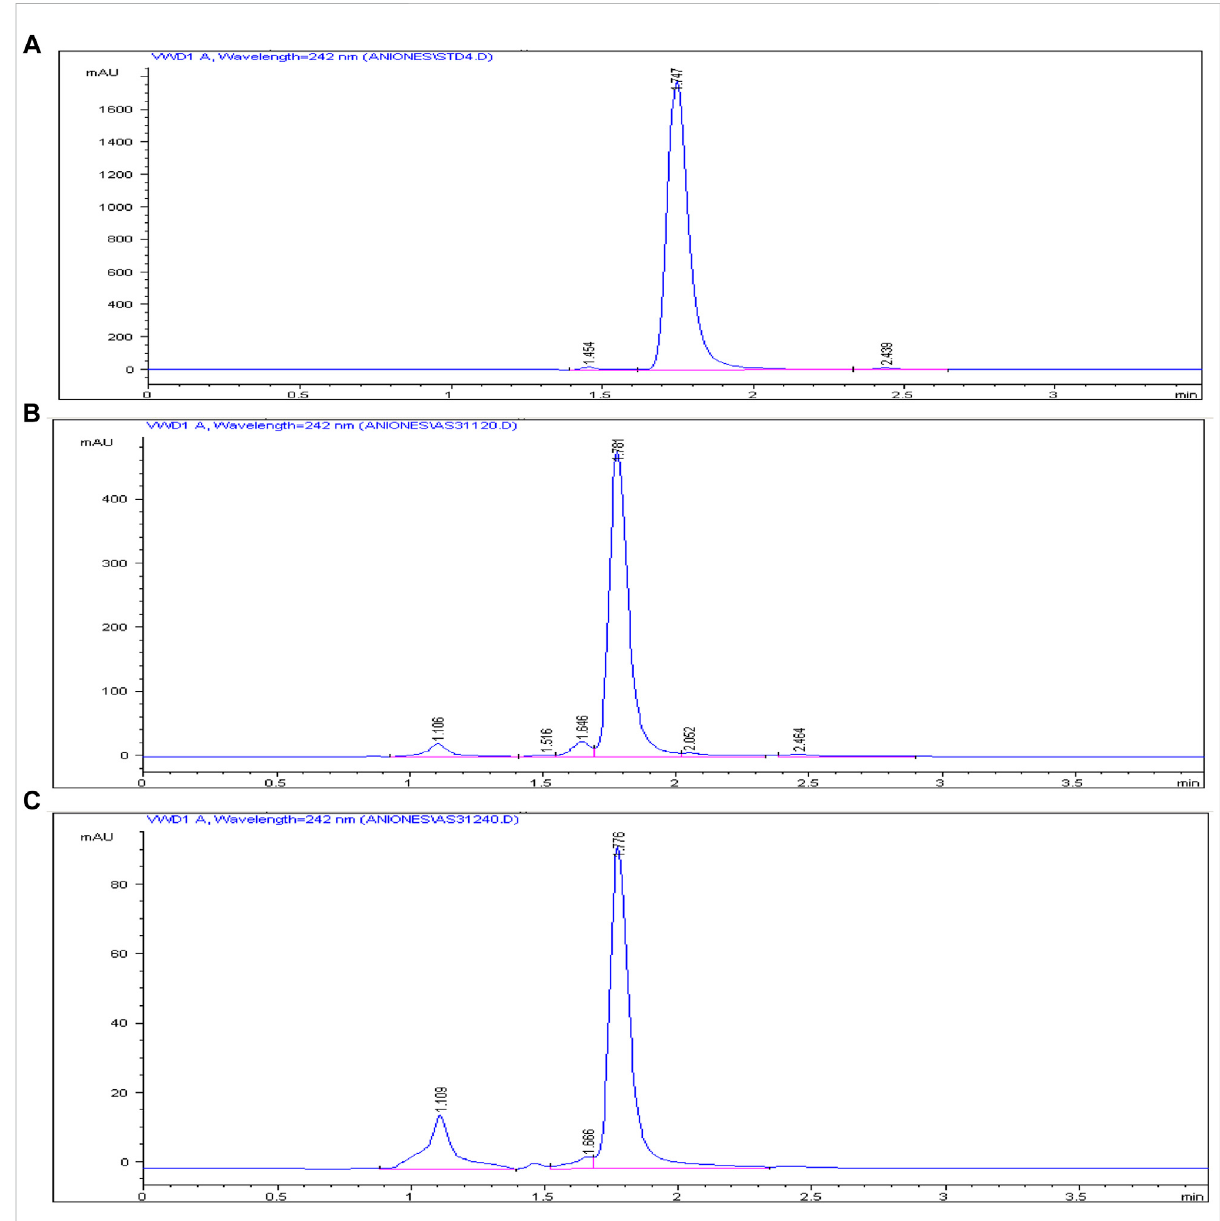
FIGURE 6 Pro fi le ofthe qualitative identi fi cationof theorganic intermediates ina sample ofACET with an initial concentration of100 mg/l (mobile phase: 60% methanol; 40% water HPLC grade; injection fl ow: 0.8 ml/min, Zorbax C-18 column). (A) Initial sample of unreacted acetaminophen. (B) Chromatogram at 1 h of reaction. (C) Chromatogram at 2 h of